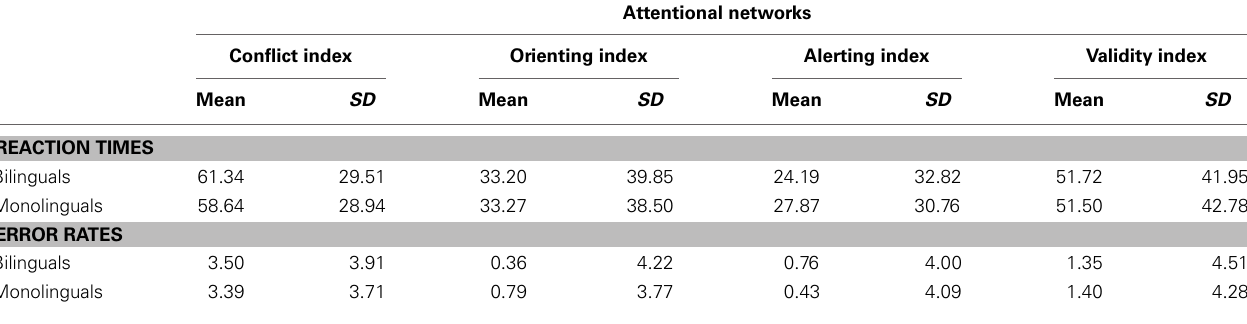
Table 3 | Attentional networks, measured as the difference in reaction times and error